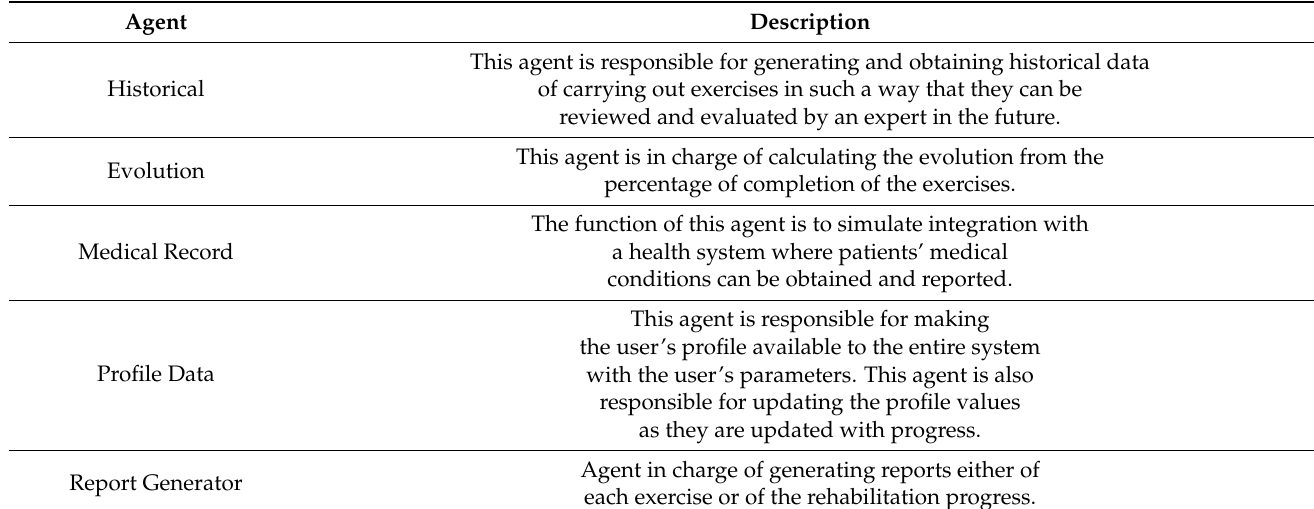
Figure 1. Proposed architecture using a multi-agent system (MAS) PANGEA. Table 1. Agents of the job monitoring